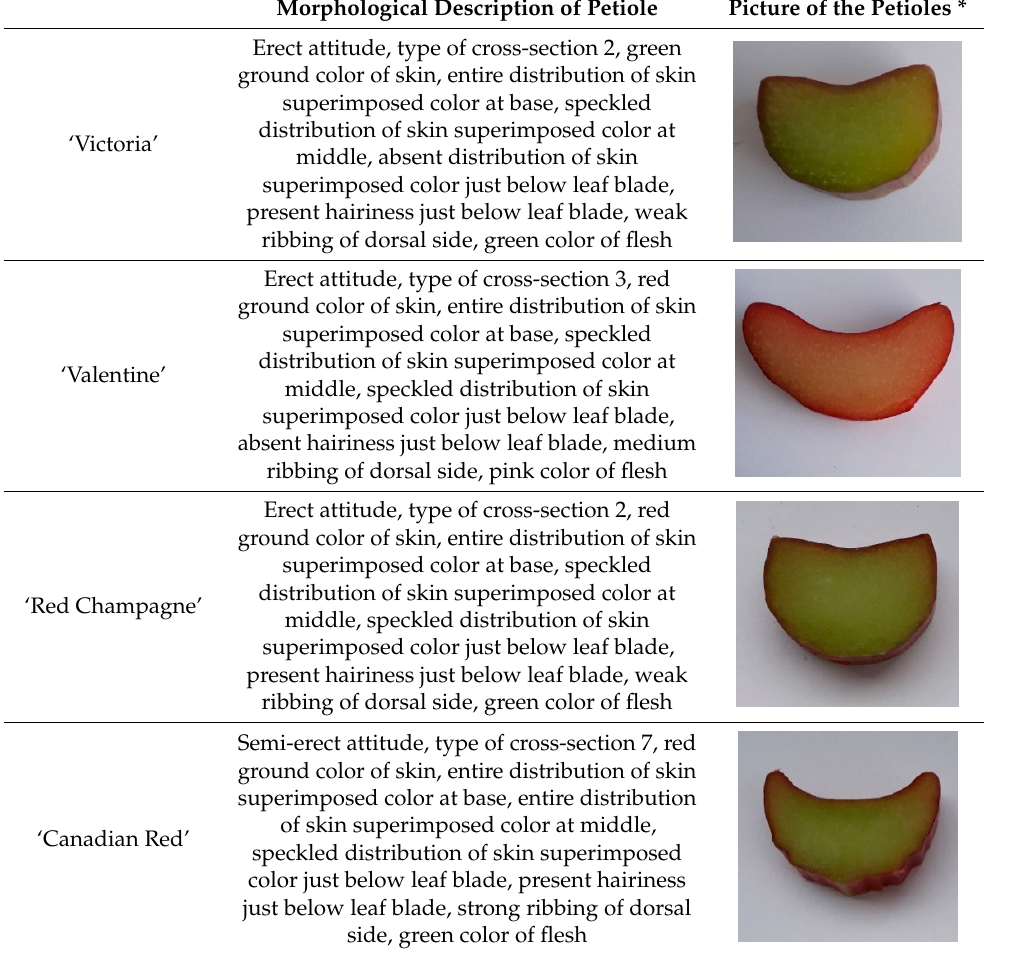
Values with different letters are significantly different at p < 0.05 by LSD test in ANOVA (Statgraphic XVII)